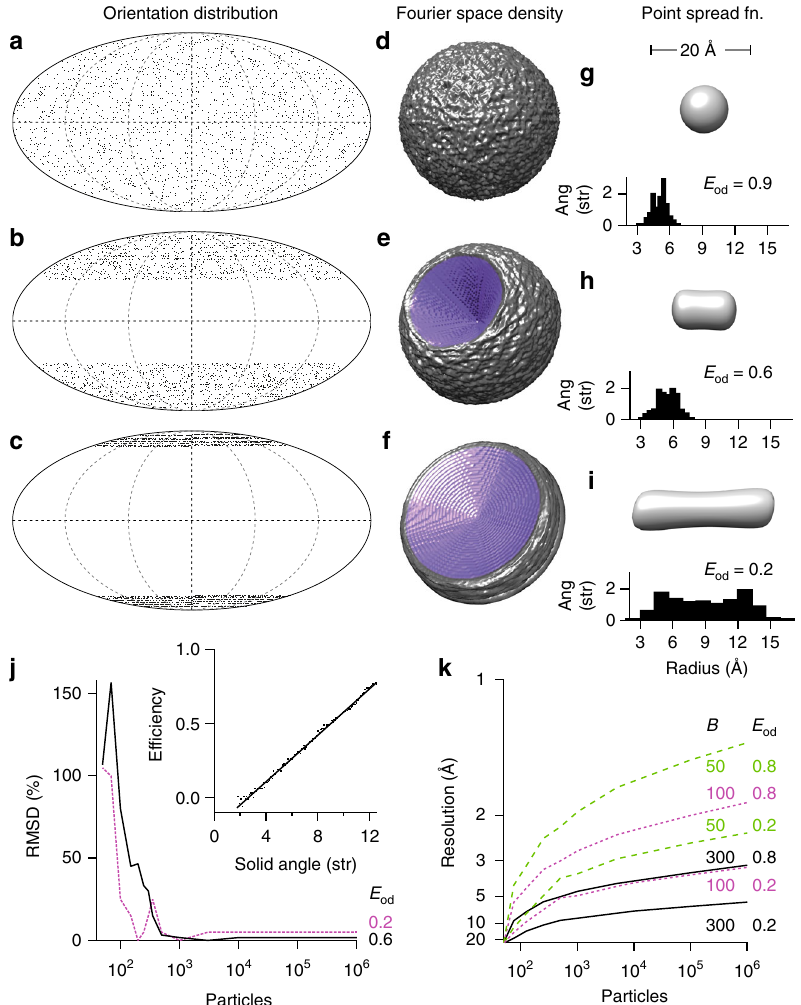
Fig. 1 Particle orientation distributions can be described by their ef fi ciency, E od . A uniformly distributed set of 10,000 particle orientations a provides uniform coverage of Fourier space d , which corresponds to a spherically symmetric PSF with a narrow distribution of radii g and high E od . A distribution with 1/3 of the views missing b , corresponds to a cone of missing density in Fourier space e , an elongated PSF with a larger variation in radii h and a reduced E od . A third distribution with 2/3 of the views missing (equiv. to a strongly preferred orientation) c corresponds to a large empty cone in Fourier space f , a strongly elongated PSF with a bimodal distribution of radii i and a low E od . The ef fi ciency is linearly related to the fraction of Fourier space covered by the orientation distribution ( j , inset ). The root mean square error (RMSD) in ef fi ciency is plotted vs. number particles used for the estimation j . The simulated relationship between the mean resolution and the number of particles used for a reconstruction is plotted k for different orientation distributions and